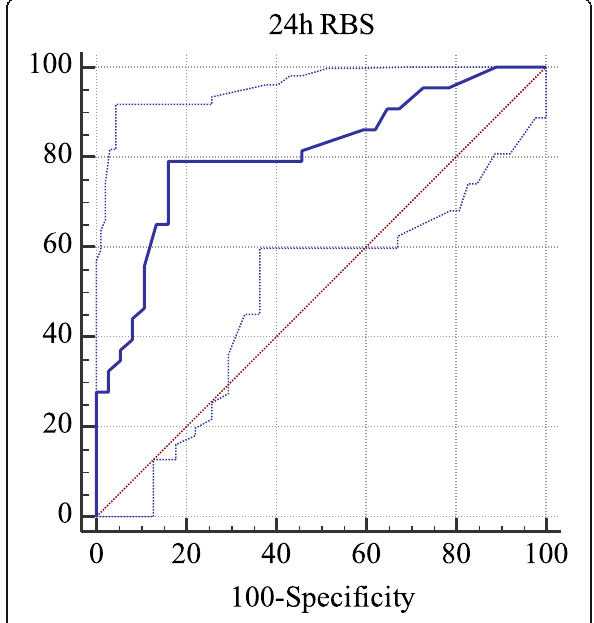
Fig. 1 Receiver operation characteristics curve analysis for mortality prediction by 24-h random blood sugar levels